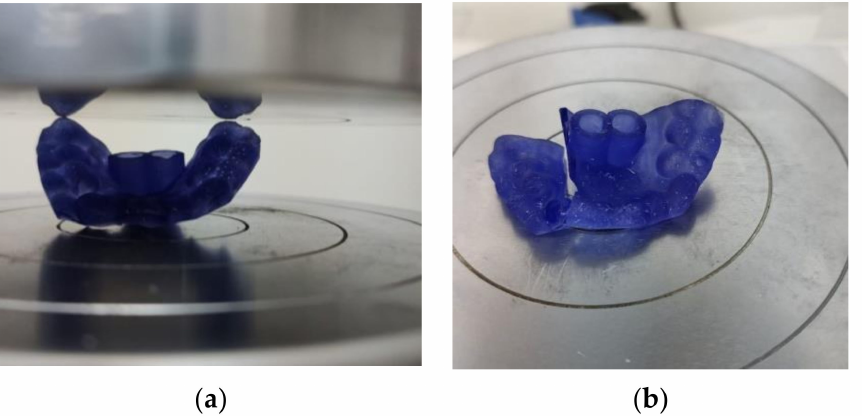
Figure 3. Experimental investigation of the surgical guides: ( a ) compression test on a guide placed between compression platens; ( b ) failure of the surgical guide subjected to compression force.